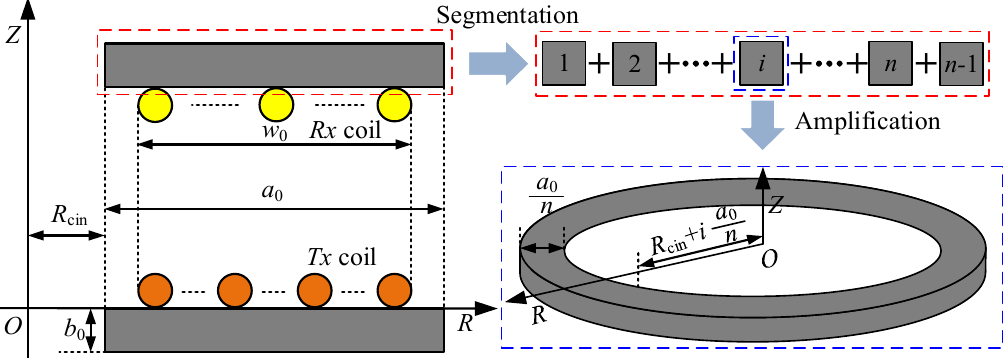
Figure 8. The schematic diagram of disk core segmentation.